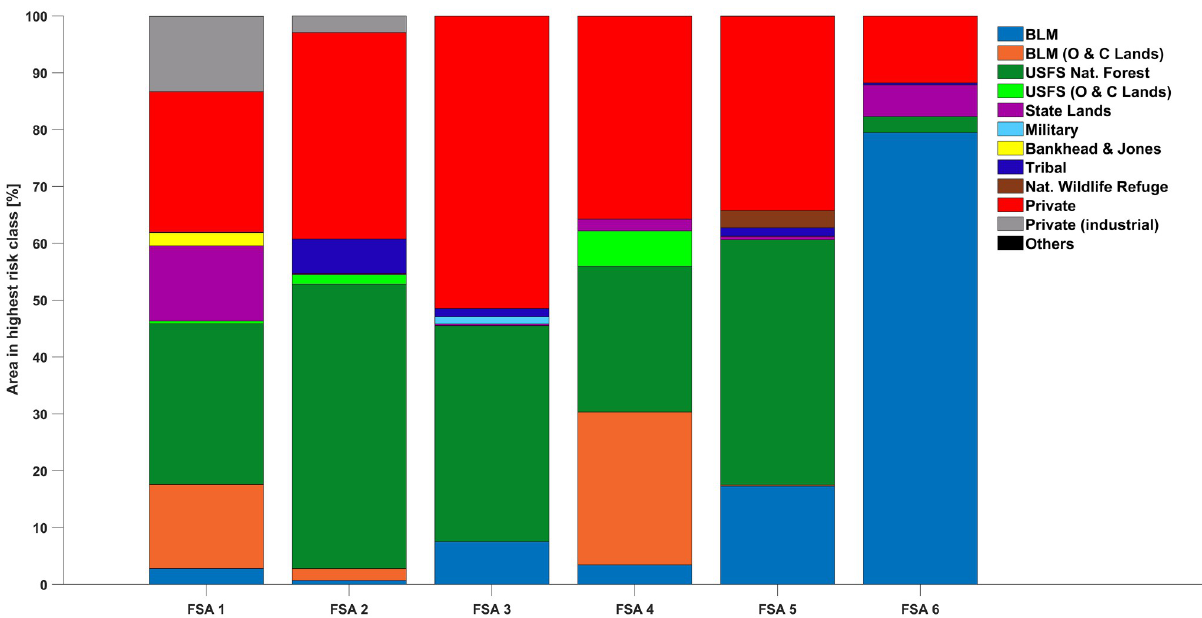
Fig 6. Percentages of land owned and managed by different entities in areas with the highest ORR within each FSA. Entities with less than 1% assigned to the highest risk class in any FSA were summarized as ‘Others’.